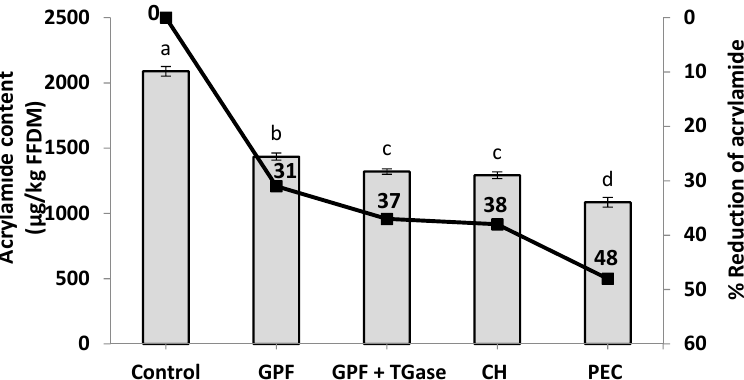
Figure 1. Effect of different hydrocolloid coatings on acrylamide content for French fries ( y -axis on the left based on fat-free dry matters (FFDM)) and % reduction of acrylamide ( y -axis on the right). Samples were coated with hydrocolloid-based coatings made of GPF, grass pea flour; GPF + TGase, grass pea flour treated by transglutaminase; PEC, pectin; CH, chitosan. “Uncoated” represents the control sample dipped in distilled water. Means with different letters (a–d) are significantly different (Tukey means comparison, p < 0.05). Data reported are the average values of three repetitions. Further experimental details are given in the text.